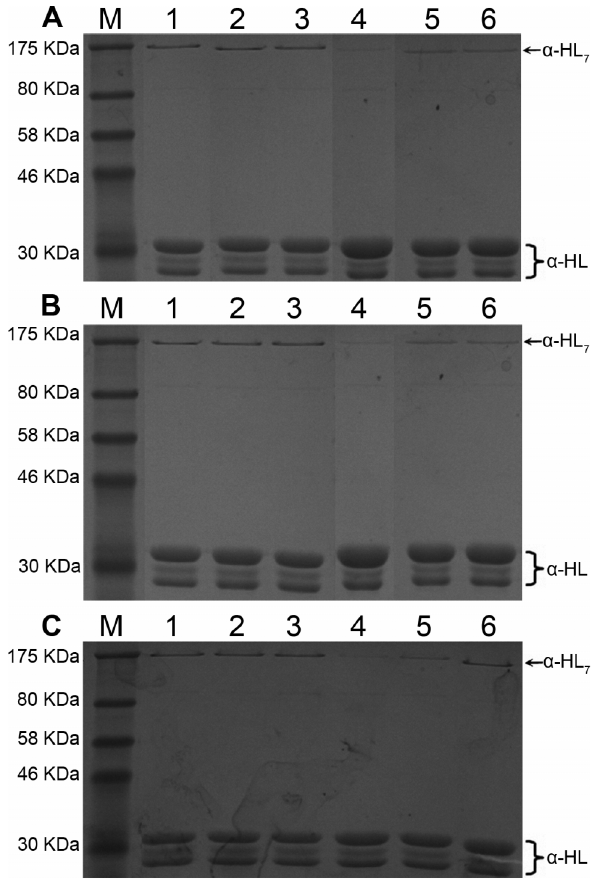
Figure 10. Detailed inhibitor-induced inhibition activation mechanism of a -HL. The inhibitors OLG, ORA and ORB can bind to the ‘‘stem’’ domain of a -HL by interactions with Tyr102/Pro103/Arg104/ Tyr112 and Gly126. The ligands can form strong interactions with both sides of the binding cavity. Because of the ligands binding with the ‘‘stem’’ domain of a -HL, the conformational transition of a -HL from the monomeric a -HL to the oligomer was restricted, which leads to the inhibition of the hemolytic activity of a